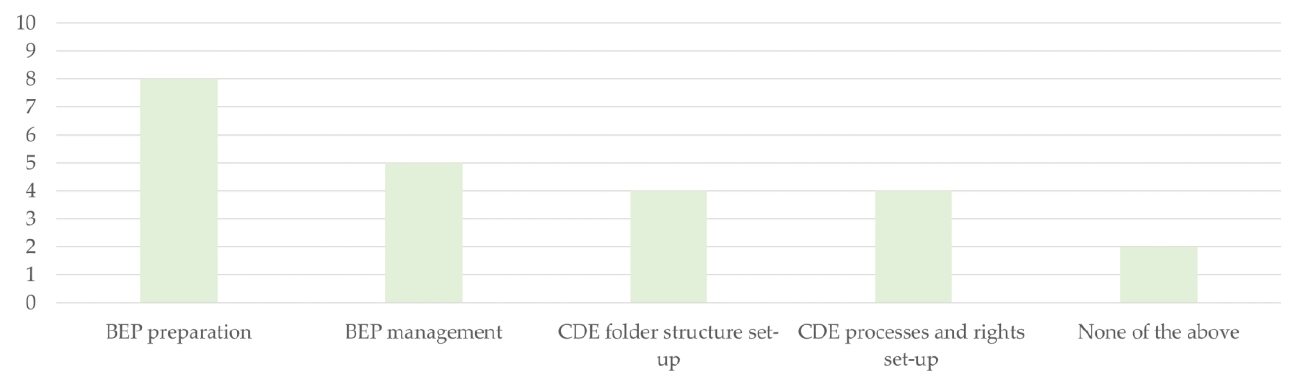
Figure 6. Responses to the question: “Which of the following tasks have been done by your team in the project?—part Project Management”.